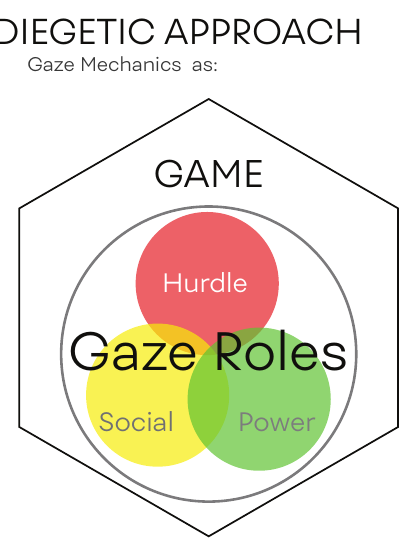
Figure 2. Diegetic Design approach with gaze